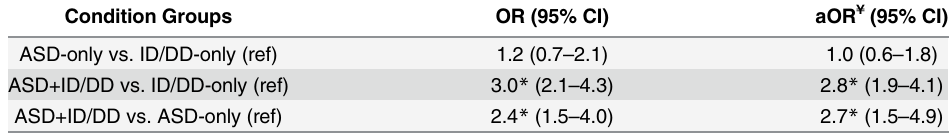
Table 8. Between-group Comparisons of the Odds of Any Preventive Measure